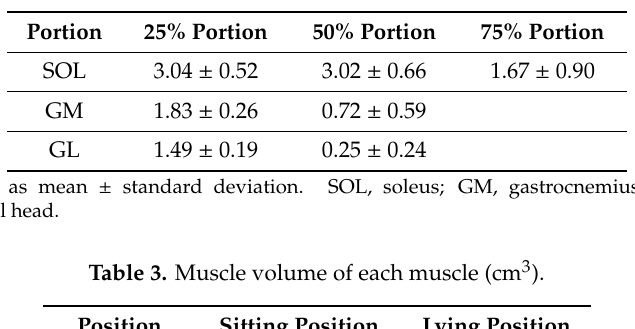
Table 2. Muscle thickness by ultrasonography in the sitting position (cm).